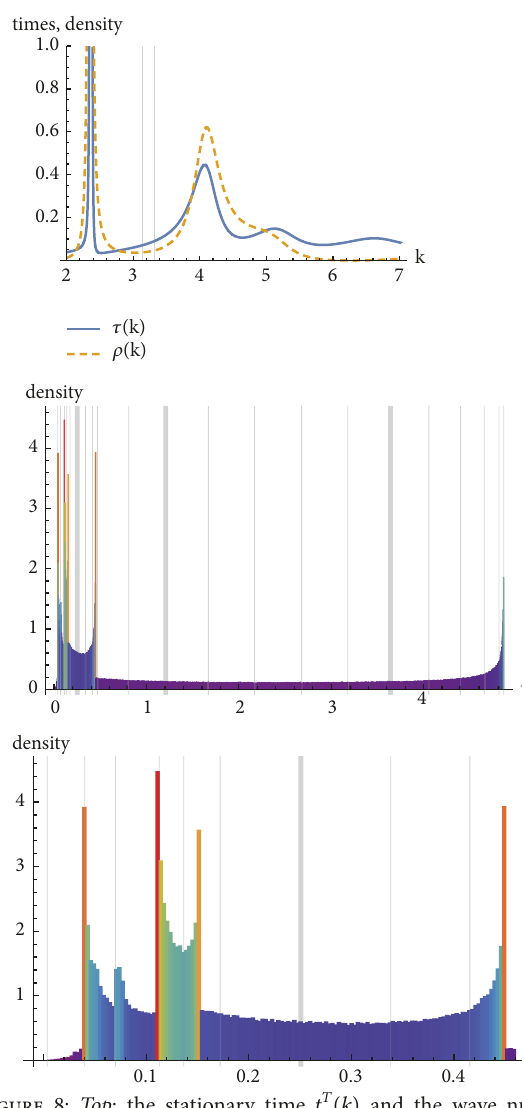
Figure 8: Top : the stationary time 𝑡 𝑇 𝑐 (𝑘) and the wave number distribution 𝜌(𝑘) , for 𝑉 0 = 11 , barrier width 𝑏 − 𝑎 = 36 , 𝑘 0 = 𝜋 , and an initial state 𝜓(𝑥,0) = √2 sin 𝑘 0 𝑥 , with 𝑘 0 = 𝜋 . The vertical lines correspond to 𝑘 = 𝑘 0 and 𝑘 = √𝑉 0 . Middle: distribution 𝜌 (𝜏) for the transmission times, with the histogram built by the 𝑡 Monte Carlo procedure described in the text. Vertical lines indicate the percentiles, as in the Figure 5. Bottom: close view of the above histogram for the range of small times. The first vertical line at the left indicates the time the light takes to cross the barrier distance. In both the histograms we used a bin length ≈ 0.0031 𝑎.𝑢. ≈ 0.15 attoseconds. Rydberg atomic units were used in all these